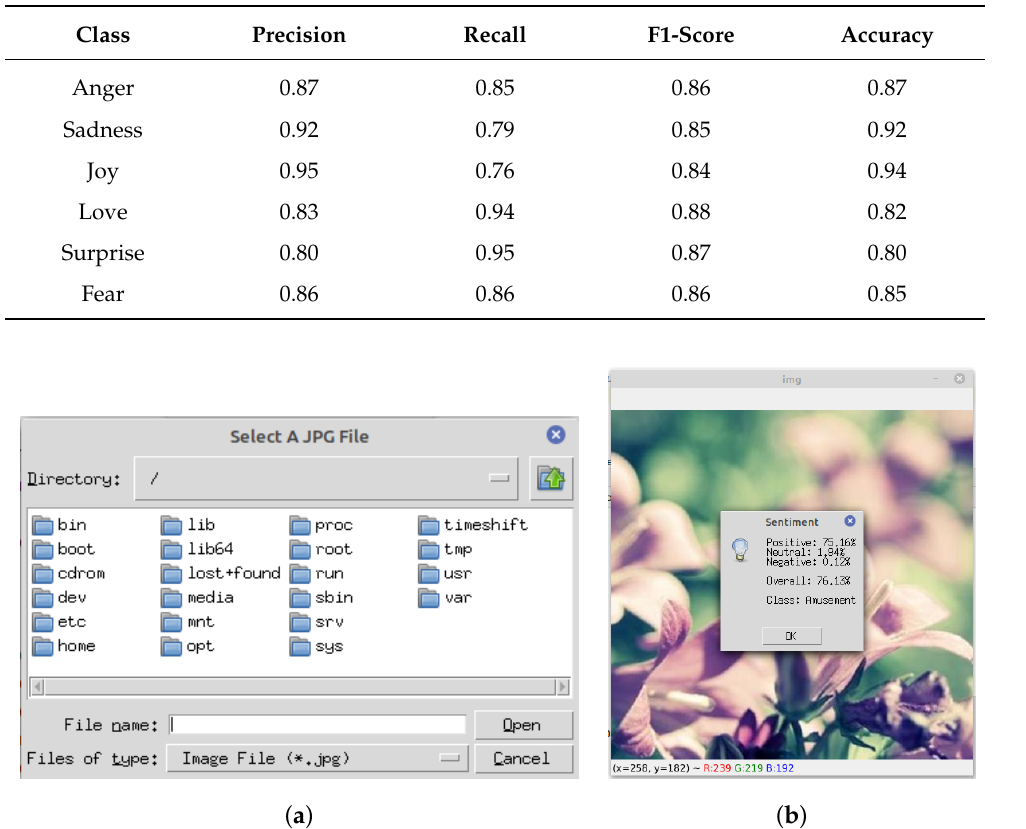
Table 8. Evaluation metrics.